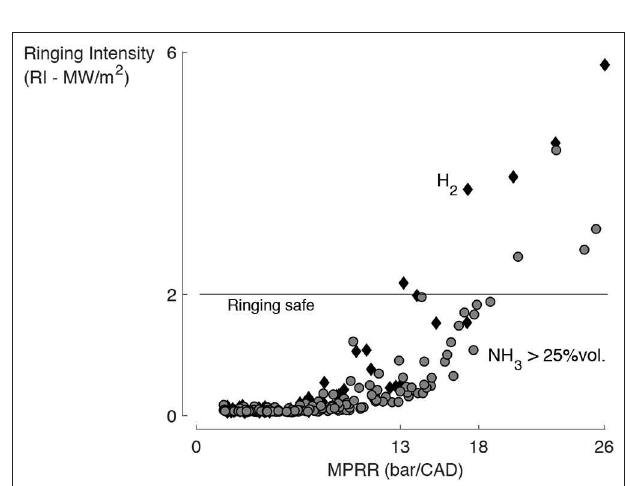
FIGURE 7 | The RI is correlated to the MPRR, and ammonia reduces both the onset and the slope of the correlation (all experimental points).